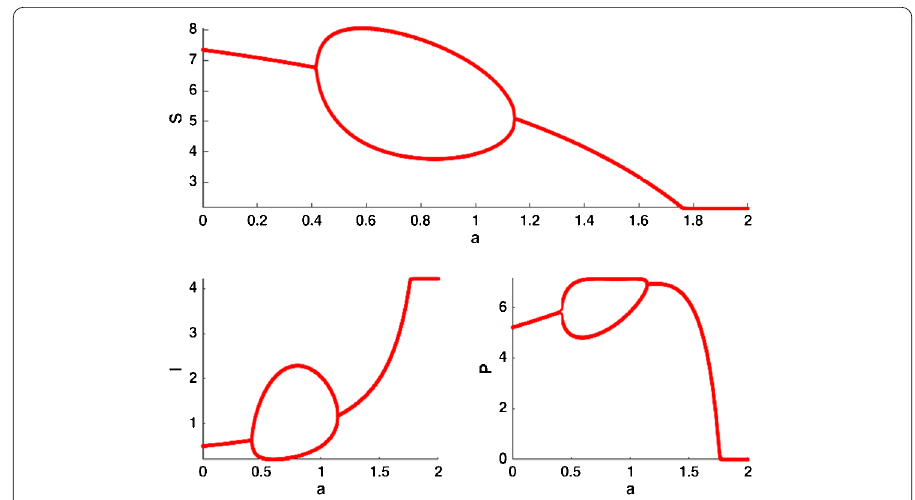
Figure 11 Bifurcation diagram of the fractional-order model (3) with respect to half saturation constant ( a ) when q = 1